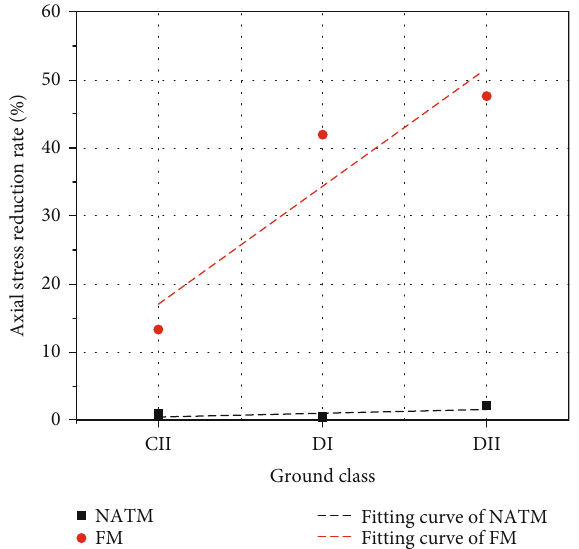
Figure 16: The axial stress reduction rate on lining concrete for tunnels constructed by di ff erent methods.